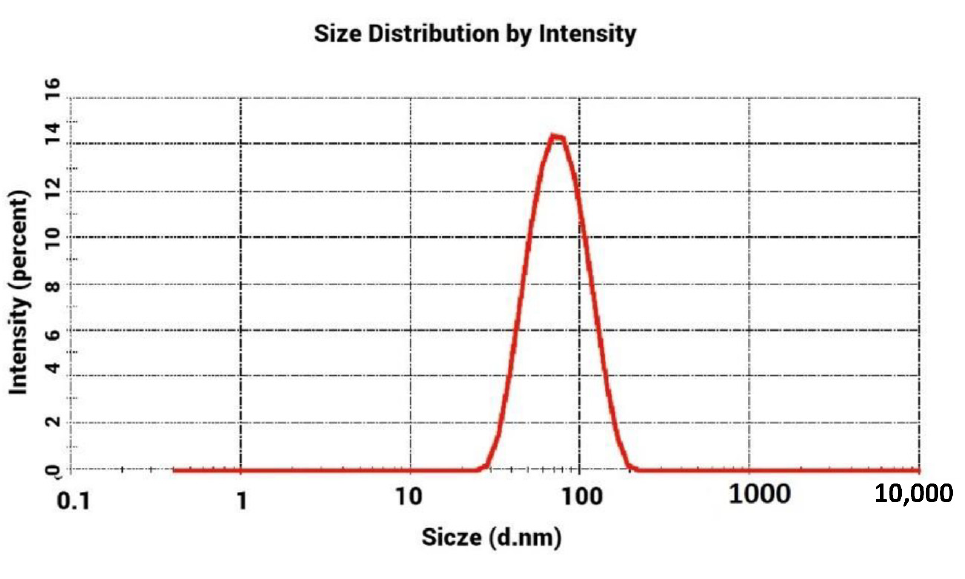
Figure 2. DLS spectrum.